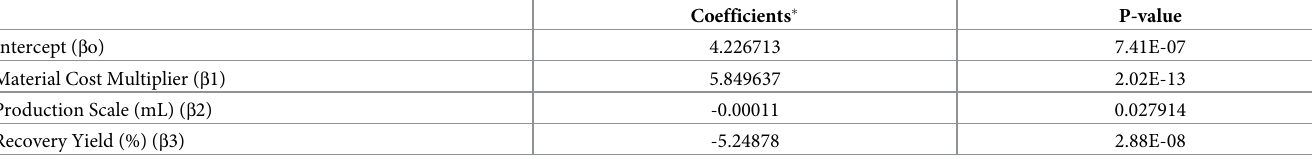
Table 4. Multiple linear correlation between material cost multiplier, production scale, and recovery